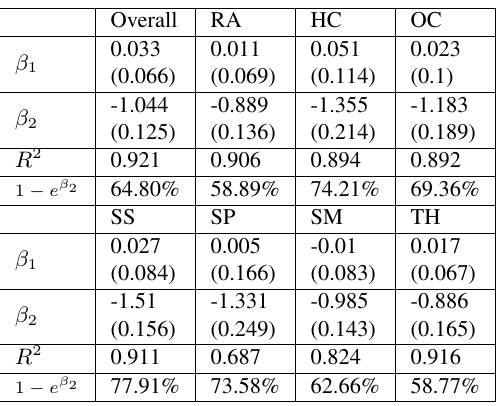
Table 4. The net effect of COVID-19 on shared-bike usage obtained via DID, with all the value of During